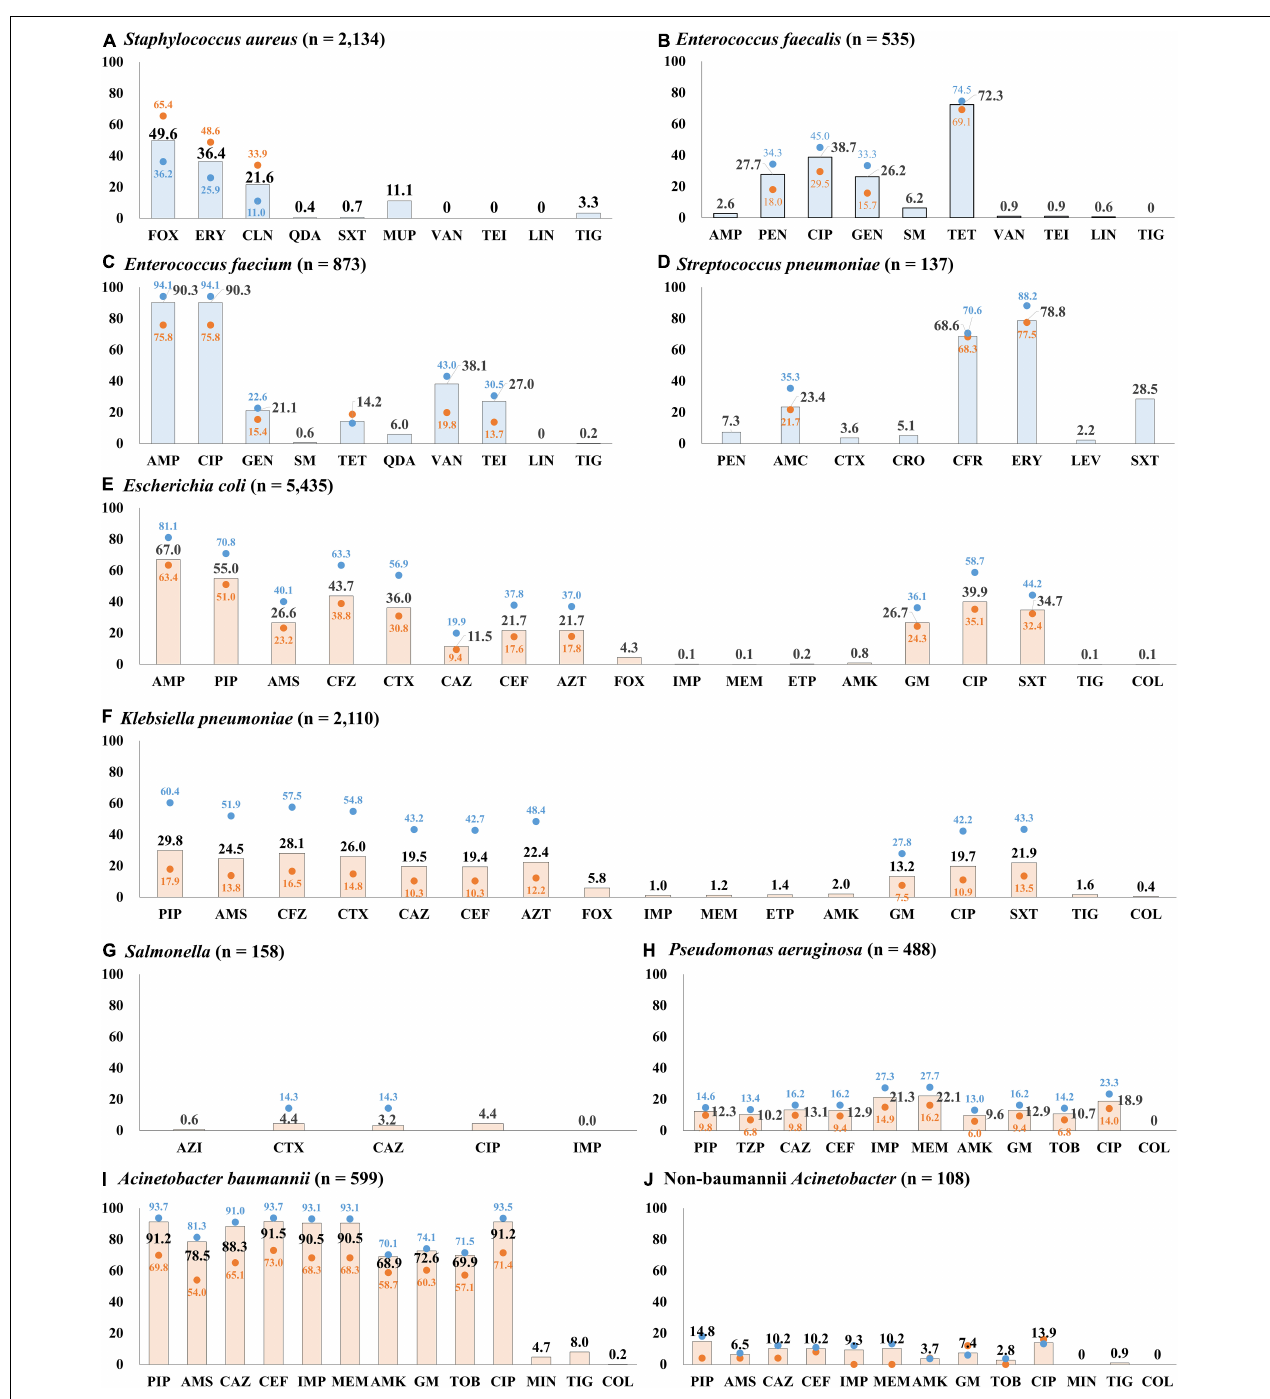
FIGURE 4 | Percentage of resistance to major antimicrobials by infection origin. (A) Antimicrobial resistance rates of S. aureus blood isolates. (B) Antimicrobial resistance rates of E. faecalis blood isolates. (C) Antimicrobial resistance rates of E. faecium blood isolates. (D) Antimicrobial resistance rates of S. pneumoniae blood isolates. (E) Antimicrobial resistance rates of E. coli blood isolates. (F) Antimicrobial resistance rates of K. pneumoniae blood isolates. (G) Antimicrobial resistance rates of Salmonella blood isolates. (H) Antimicrobial resistance rates of P. aeruginosa blood isolates. (I) Antimicrobial resistance rates of A. baumannii blood isolates. (J) Antimicrobial resistance rates of non-baumannii Acinetobacter blood isolates. The bars indicate the resistance rates of total blood isolates, the blue dots indicate those of isolates from hospital-originated infection, and the red dots indicate those of isolates from community-originated infection. Abbreviations: AMC, amoxicillin-clavulanate; AMK, amikacin; AMP, ampicillin; AMS, ampicillin-sulbactam; AZI, azithromycin; AZT, aztreonam; CAZ, ceftazidime; CEF, cefepime; CFR, cefuroxime; CFZ, cefazolin; CIP, ciprofloxacin; CLN, clindamycin; COL, colistin; CRO, ceftriaxone; CTX, cefotaxime; ERY, erythromycin; ETP, ertapenem; FOX, cefoxitin; GEN, gentamicin; IMP, imipenem; LEV, levofloxacin; LIN, linezolid; MEM, meropenem; MIN, minocycline; MUP, mupirocin; PEN, penicillin; PIP, piperacillin; QDA, quinupristin-dalfopristin; SM, streptomycin; SXT, trimethoprim-sulfamethoxazole; TEI, teicoplanin; TET, tetracycline; TIG, tigecycline; TOB, tobramycin; TZP, piperacillin-tazobactam; VAN,